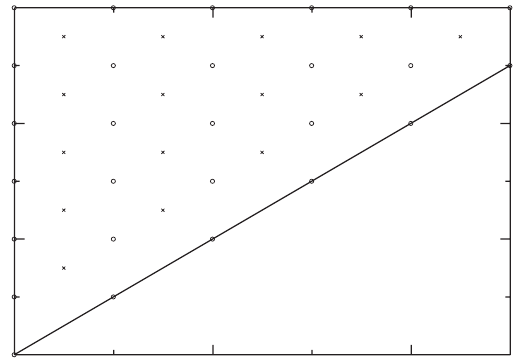
Figure 4.1 . Numerical grid for the direct algorithm. Circles indicate grid points, and the dynamic equations are applied at cell centers, indicated by ×